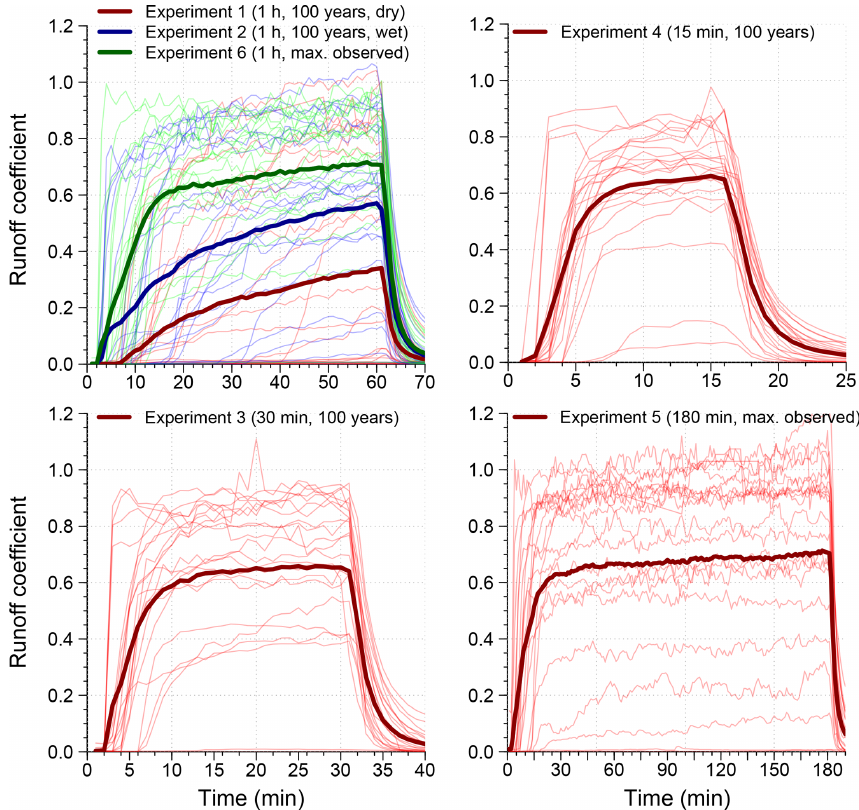
Figure 8. Overview of hydrographs from all experiments, separately displayed for the individual durations and return